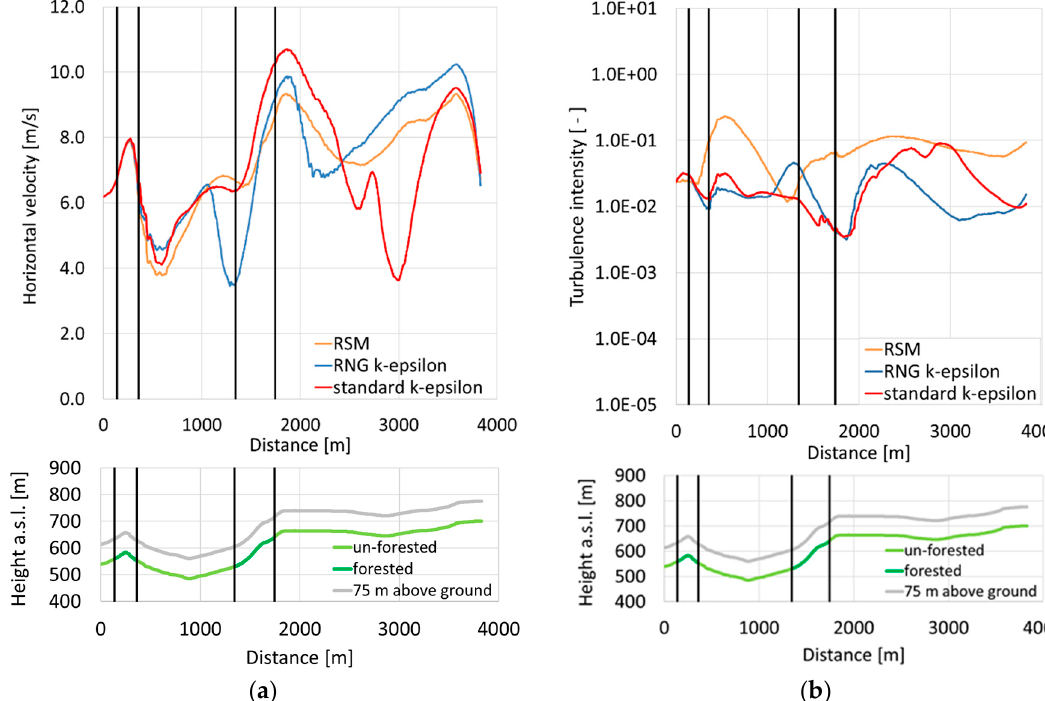
Figure 7. ( a ) Horizontal velocity at a constant distance of 75 m above the ground (grey line); ( b ) turbulence intensity at a constant distance of 75 m above the ground (grey line). Computation 2018 , 6 , x FOR PEER REVIEW